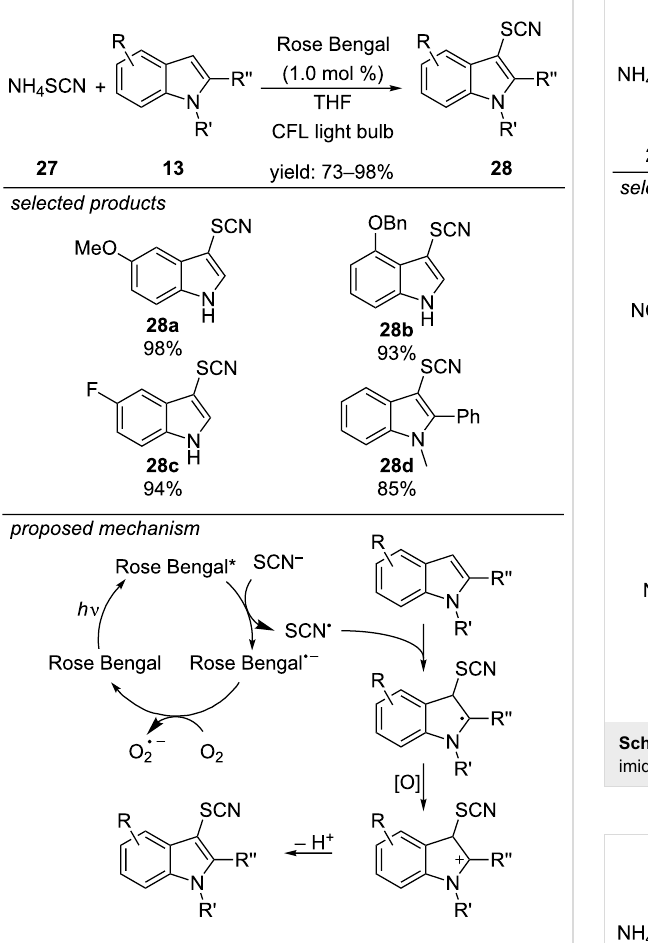
Scheme 25: Li’s visible-light photoredox-catalyzed thiocyanation of indole derivatives with Rose Bengal as photocatalyst.